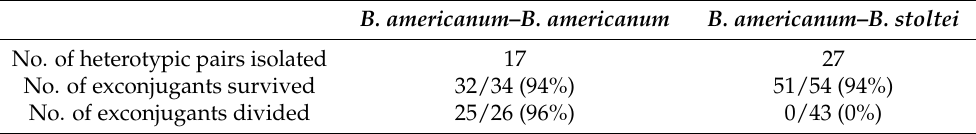
Table 4. Exconjugants that survived after intra- and inter-species